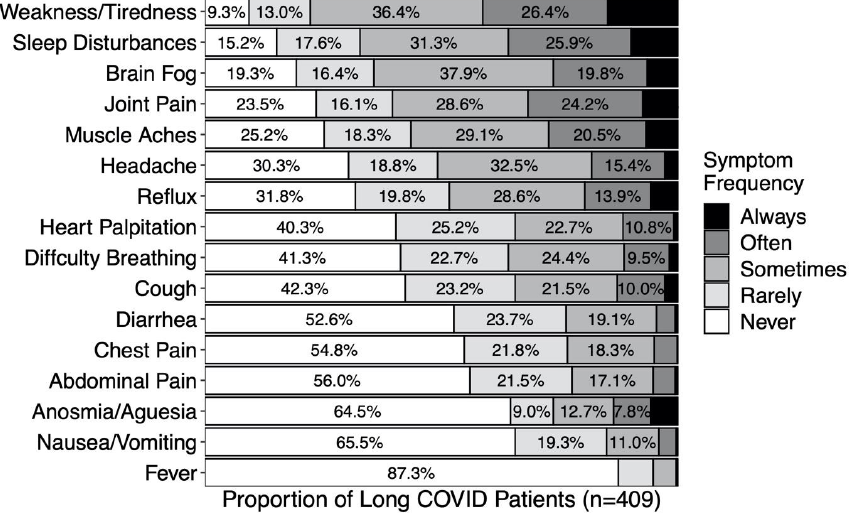
Figure 1. Proportion of patients reporting Long COVID symptoms at various frequencies over the preceding two weeks. Table 1. Participant sociodemographic and clinical